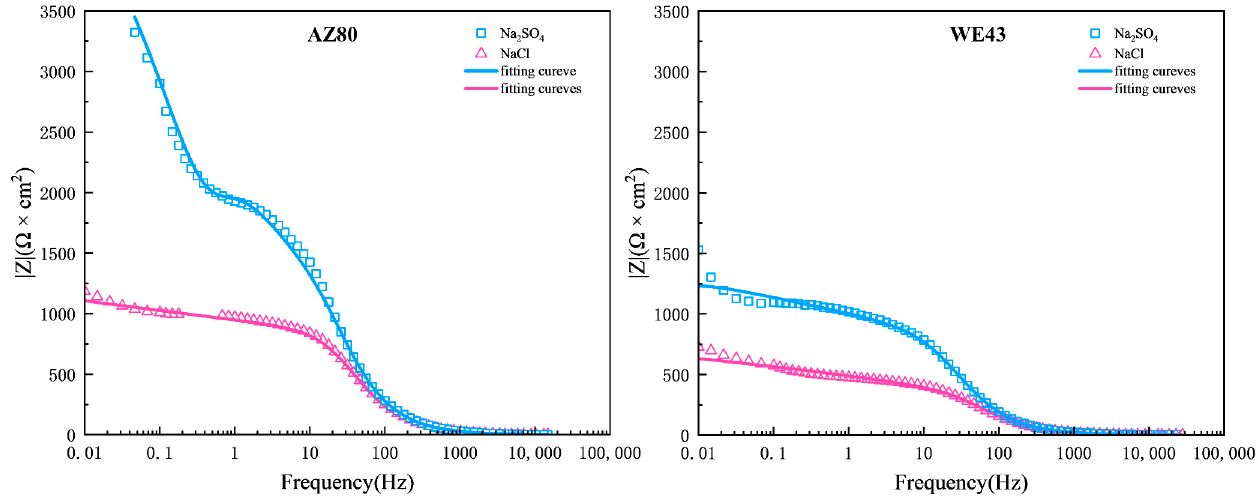
Figure 12. Amplitude diagram (|Z| vs. f) of AZ80 and WE43 alloys in 0.6 M NaCl and Na 2 SO 4 solution.